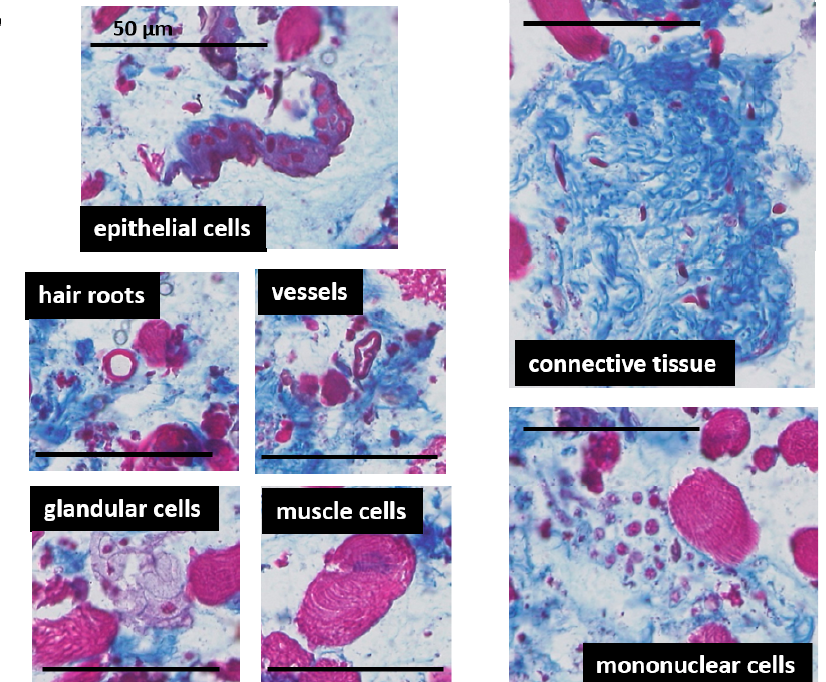
Figure 1. Tissue fragments in micrografted skin solution. ( A ) Normal skin tissue was minced by Rigeneracons ® . Obtained tissues were stained with HE and observed under a microscope; ( B ) Obtained tissue was also stained with Masson’s trichrome (MT), which contained all of the skin elements, including epithelial cells, hair roots, vessels, glandular cells, muscle cells and mononuclear cells. Connective tissue is also included. Scale bars = 50 μ m.